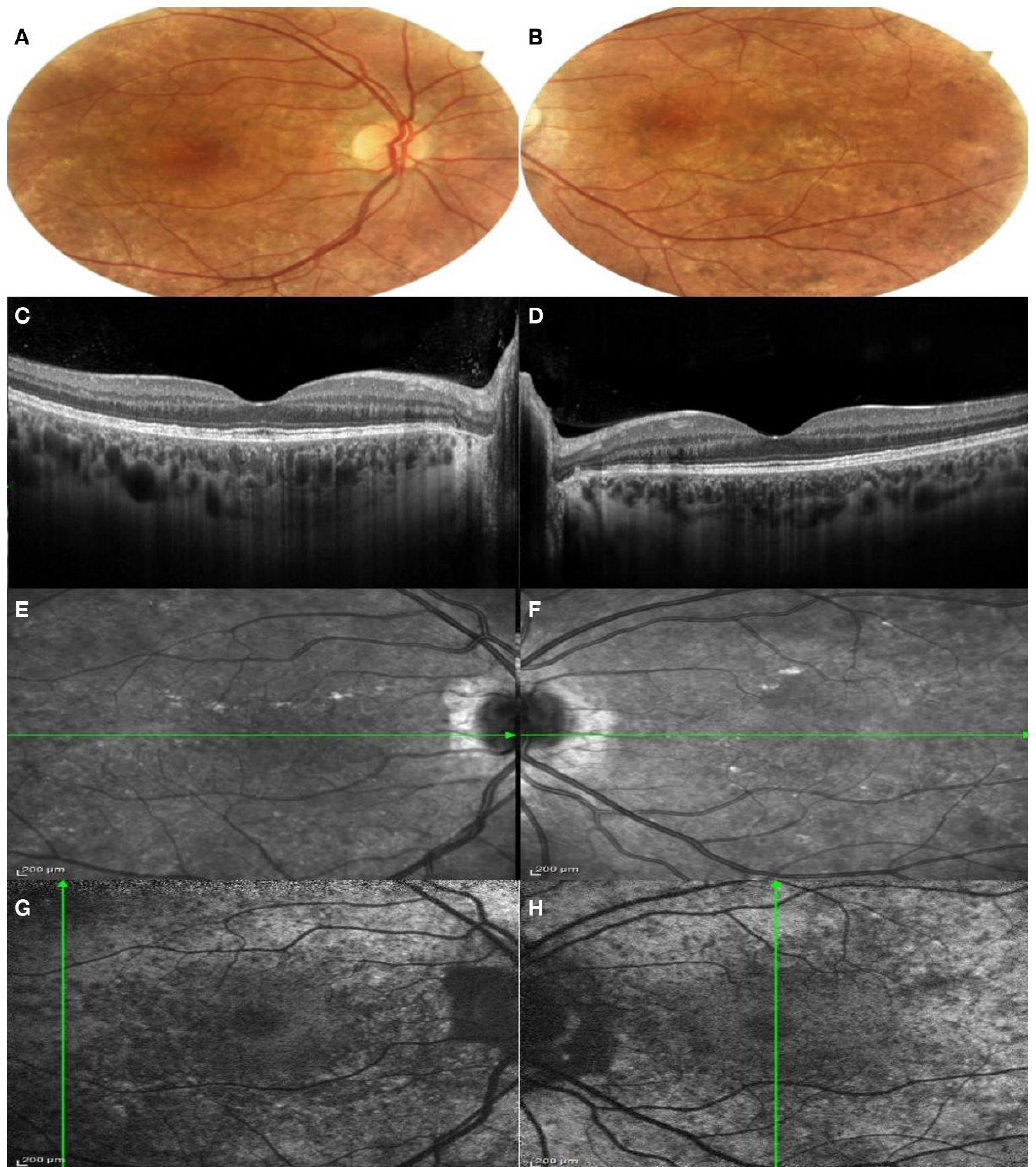
Figure 5. Multimodal imaging of both eyes of Patient II:2. ( A , B ) Color fundus photography of both eyes showed mild peripapillary atrophy, areas of hyper-pigmentation in the perifoveal area and pigmentary changes at the level of the vascular arcades; ( C , D ) SD-OCT of both eyes showed thinning of the ONL in the perimacular zone. IZ-EZ and the RPE–Bruch’s complex were irregular, with spot of hyper-transmission posterior to the RPE-Bruch’s membrane; ( E , F ) IR images showed normal aspect of the macular area and hypo-reflective areas among the vascular arcades; ( G , H ) normal autofluorescence of the macular area and a generalized hypo-fluorescence of the vascular arcade area. ( A , C , E , G ): right eye; ( B , D , F , H ): left